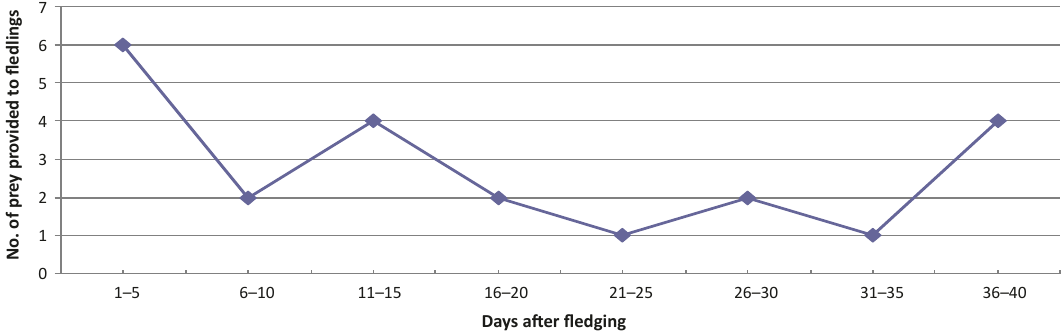
Days after fledging Figure 3. Number of prey brought to fledglings at morning or eveing or average when both observed the same day. Figure 3. Number of prey brought to fledglings at morning or evening or average when both observed the same